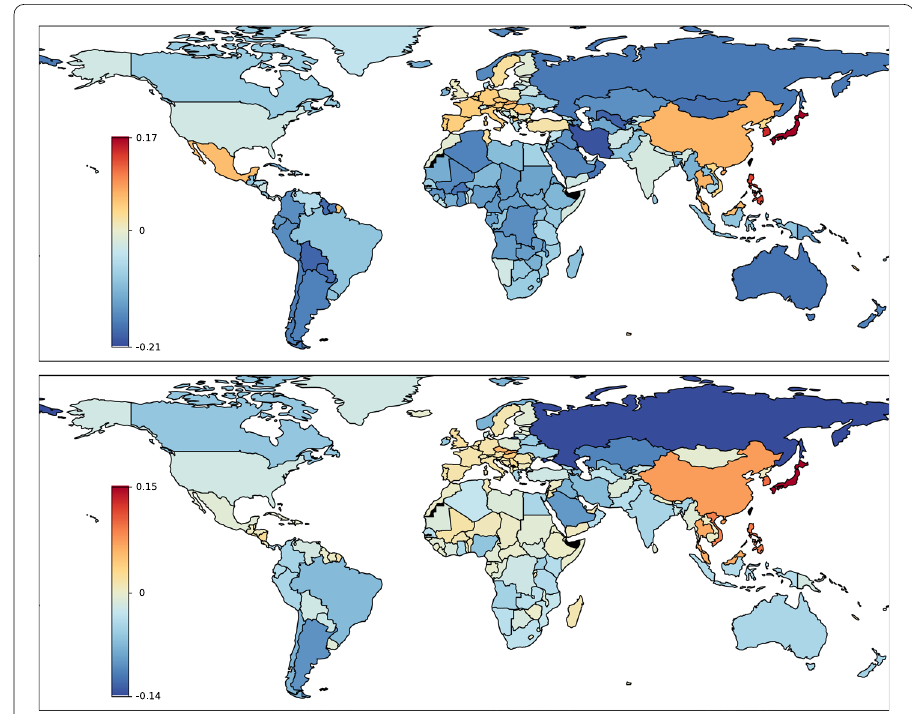
Fig. 4 Sensitivity of country balance. Same as in Fig. 3 but for product s = 7 (machinery). Data are shown for year 2018 (similar data for years 2012, 2014, 2016 are given in Additional file 1: Fig.